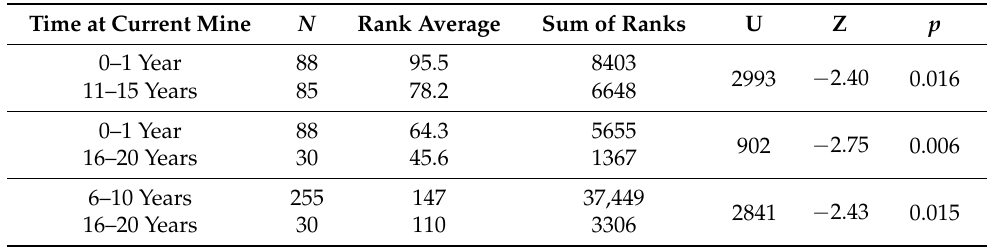
Table A8. Mann-Whitney results for mining experience and confidence in one’s ability to correctly explain or demonstrate “how to read mine map symbols”.